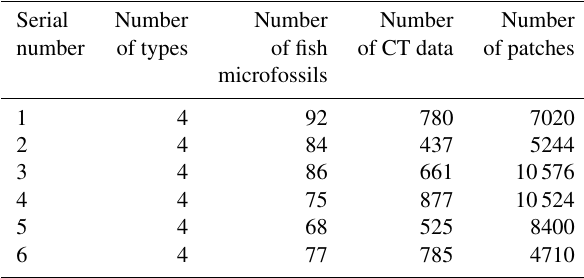
Table 1. Details of experimental datasets. Table 2. Global IoU macro scores of the binary image segmentation